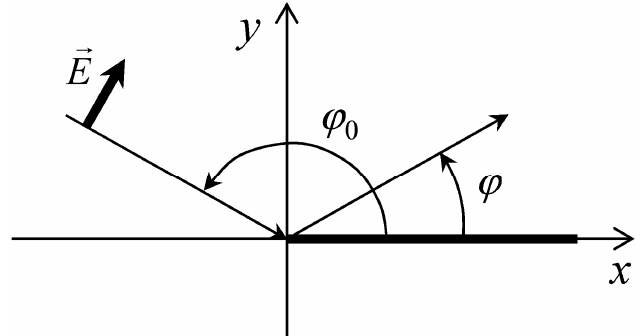
Figure 1. The geometry of the